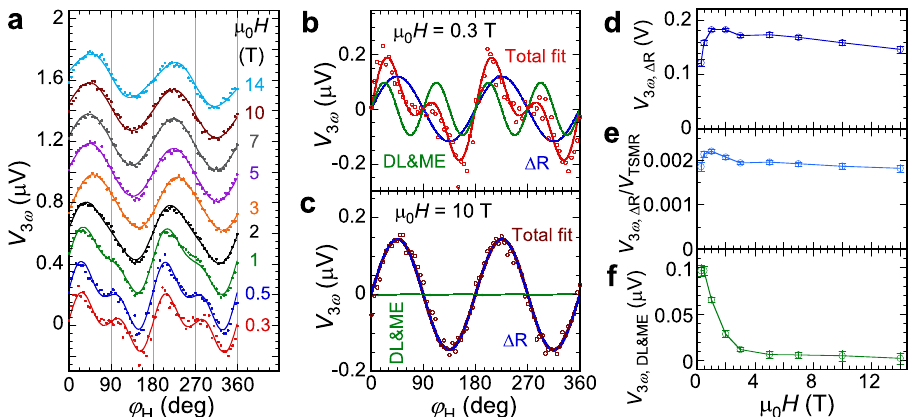
Fig. 3 Third harmonic results. a In-plane angular dependence of third harmonic Hall voltage V 3 ω at different magnetic fi elds for a Pt ( 5nm)/ α -Fe 2 O 3 (30nm) bilayer at 300K. Angular dependence of V 3 ω at b 0.3T and c 10T, where the blue curve is from the change of Pt resistivity ( Δ R ), the green curve is from the damping-like (DL) torque and the magnetoelastic effect (ME) (they have the same angular dependence), and the red curve is the total fi t by Eq. (3). Field dependencies of d V Δ R , e V Δ R normalized by thetransverse spinHall magnetoresistance (TSMR) signal V TSMR , and f V DL þ ME 3 ω 3 ω